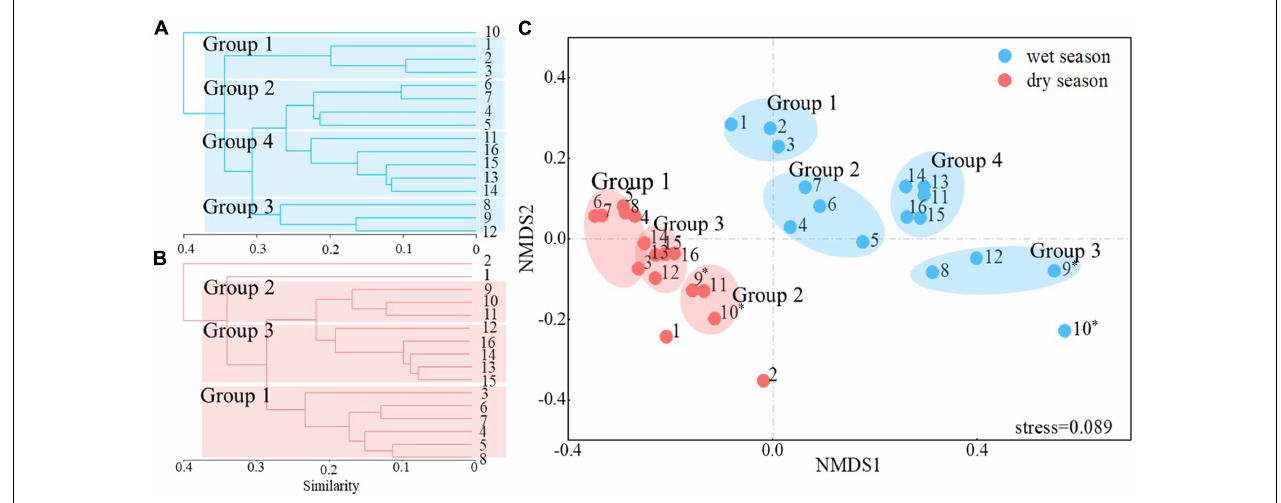
FIGURE 3 | Cluster analysis and non-metric multidimensional scaling (NMDS) ordinations of Bray–Curtis distances among communities from 16 sampling sites. The numbers 1–16 correspond to the sampling sites Y01–Y16. Cluster analysis of bacterioplankton communities in the wet season (A) and dry season (B) . Based on the NMDS plots (C) , groups 1, 2, 3, and 4 are shown in blue and represent the five groups in the wet season. In addition, groups 1, 2, and 3 are shown in red and represent the three primary dry season groups. * indicates that the samples were collected in the region of the Jiangkou